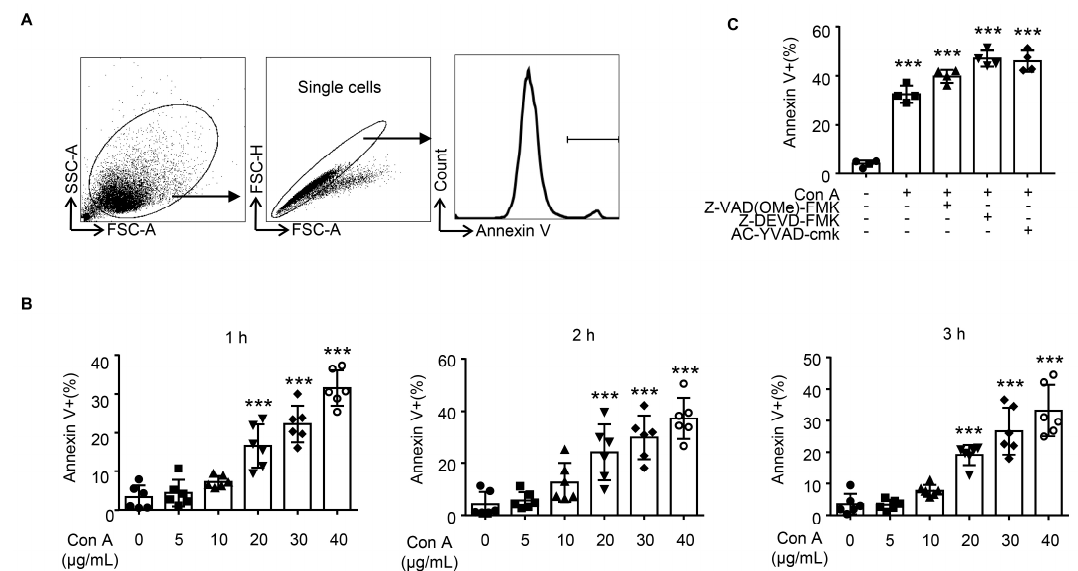
Figure 3. Con A treatment leads to hepatocyte apoptosis in vitro. AML12 cells were treated with or without Con A at various final concentrations for 1, 2, or 3 h, and the cells were then incubated with annexin V. ( A ) Gating strategy for Annexin-positive AML12 cells. ( B ) Bar graphs depict the percentages of AML12 cells positively stained for annexin V after Con A (at various concentrations) or vehicle treatment at 1, 2, or 3 h ( n = 6 for each group). ( C ) AML12 cells were treated with various caspase inhibitors before Con A (20 mg/mL) treatment and then stained with annexin V. The percentage of apoptotic cells was measured by flow cytometry. The results of quantitative analyses of apoptosis rate are shown. ( n = 4 for each group). Each symbol represents one individual. Data are shown as means ± SD. ***, p < 0.001 vs. the control group.